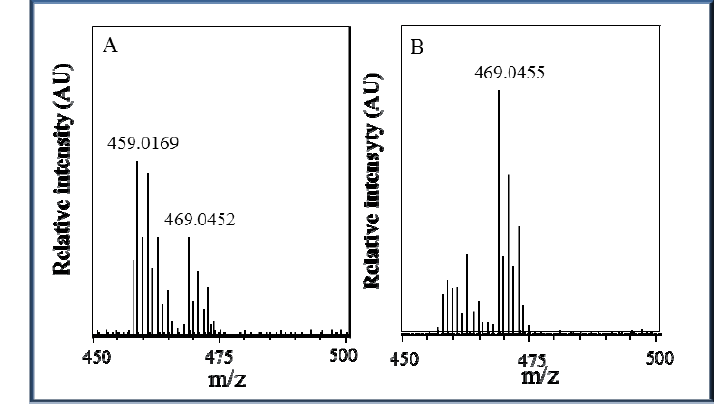
Figure 5. ESI-QTOF mass spectrum of 10 µM Zn(phen)(his)Cl from 450 to 500 m/z in 0.2 M in the presence of acetate buffer ( A ) pH 3.5 and ( B ) pH